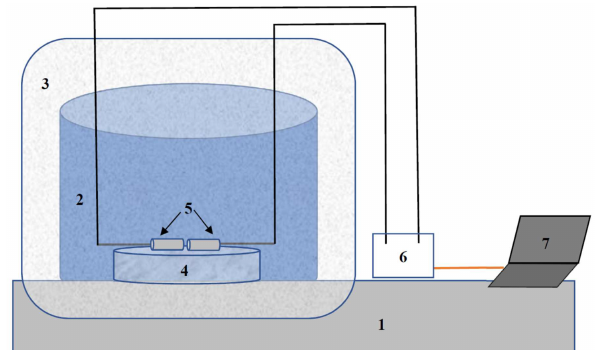
Figure 14. METH night test. Red and blue are the PSD of close METHs, green is the ADC self-noise, purple is the uncorrelated part corresponding to METH self-noise, black is sea state zero, and grey is the TC4035 Teledyne Reson hydrophone. Hz – x axis, dB √ (re 1µPa/ Hz) – y